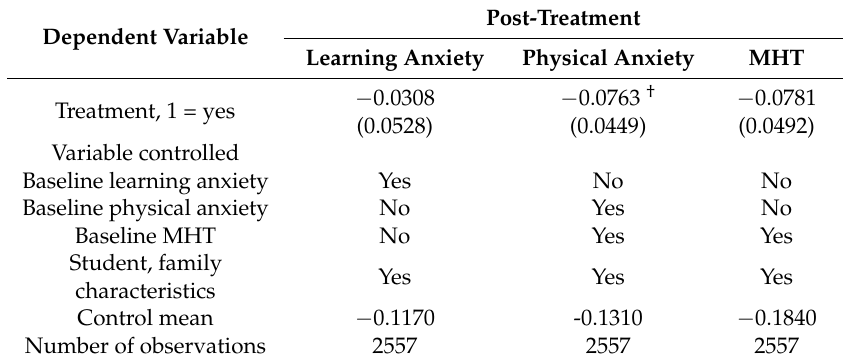
Table 2. Impact of Providing Fully Subsidized Eyeglasses on Mental